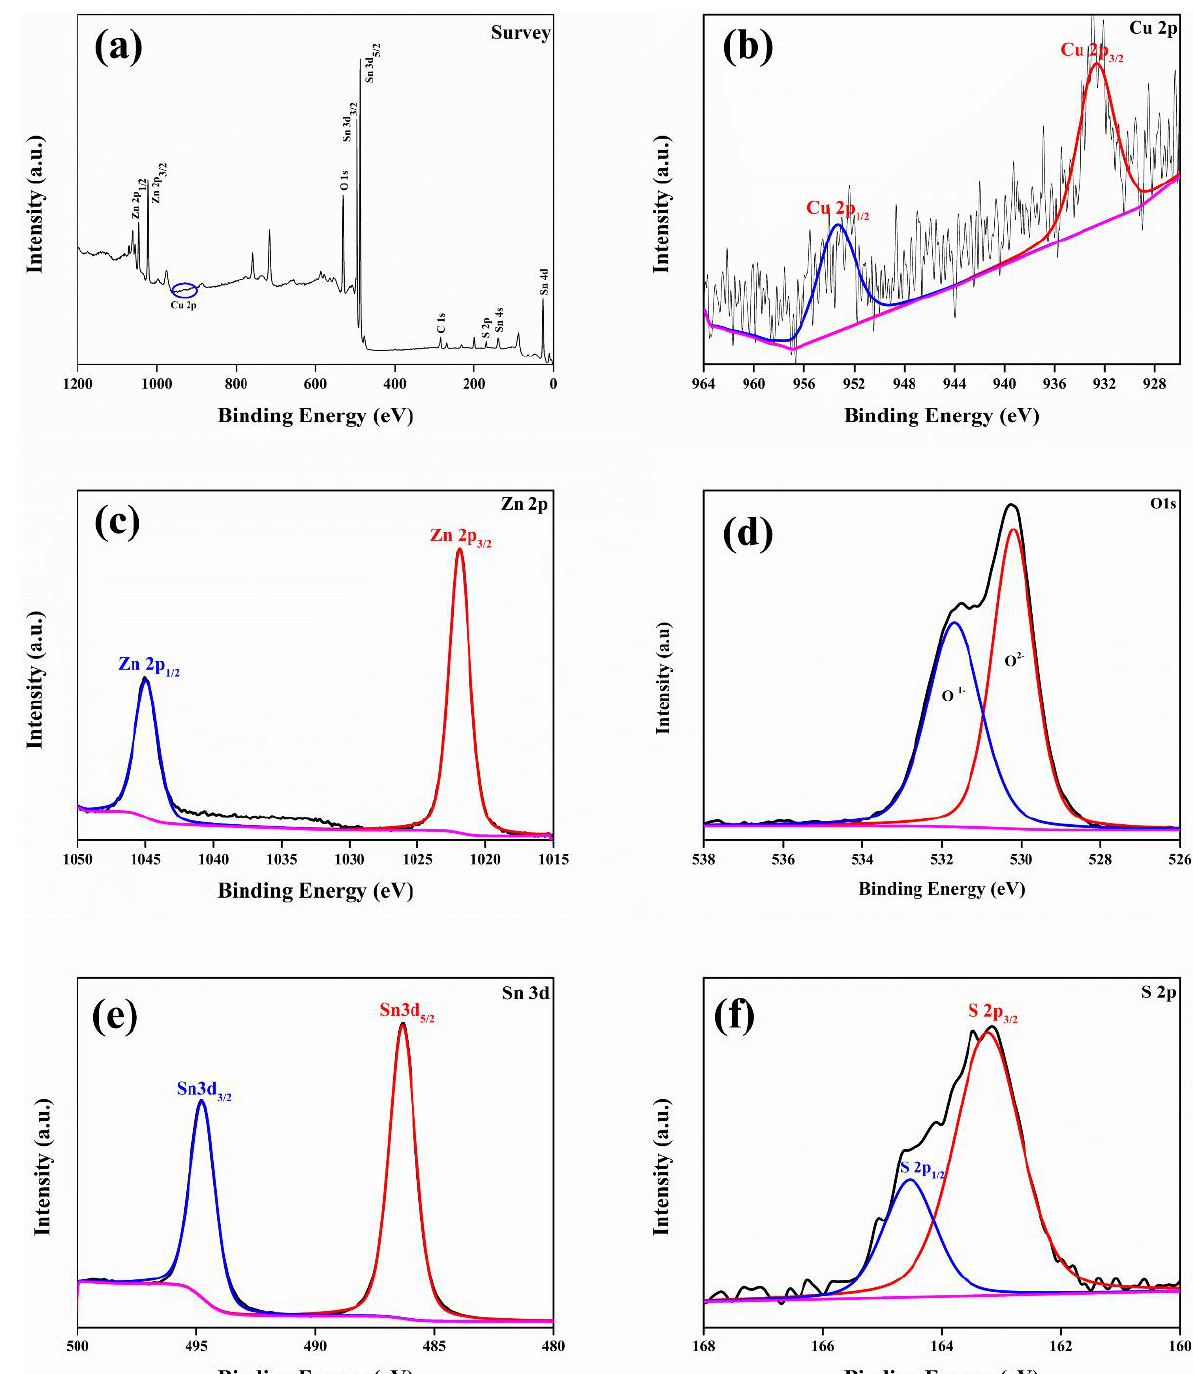
Figure 3. XPS spectra of Cu 2+ -doped (3%) ZnO–SnS (ZS-C3) nanocomposite: ( a ) survey, ( b ) Cu 2p, ( c ) Zn 2p, ( d ) O 1s, ( e ) Sn 3d, and ( f ) S sp.